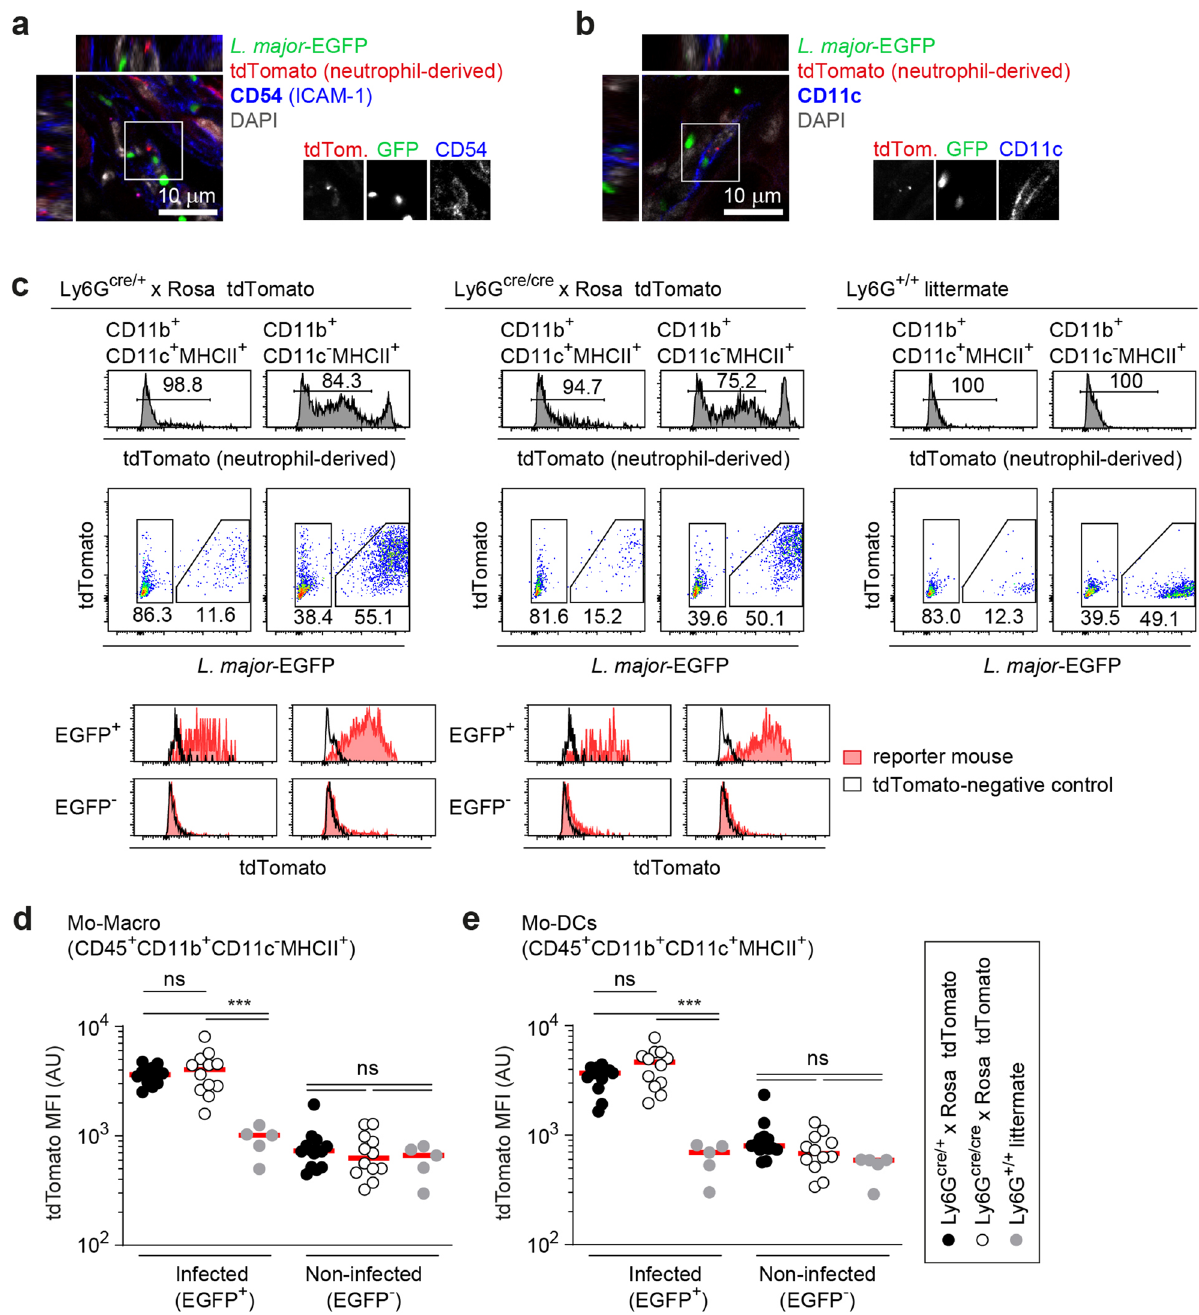
Figure 2. Uptake of neutrophil-derived material by monocyte-derived phagocytes is not altered by Ly6G-deficiency. ( a,b ) Confocal microscopy of Ly6G cre/+ × Rosa-tdTomato reporter mice infected with EGFP-expressing L. major 2 days p.i., demonstrating concomitant content of L. major parasites along with neutrophil-derived material in CD54 + ( a ) and CD11c + cells ( b ) and thus suggesting the uptake of L. major together with neutrophil material. Parasites are pictured in green and the neutrophil-derived material in red. Scale bar: 10 µm. ( c ) Flow cytometry analysis of infected cells from Ly6G cre/+ × Rosa-tdTomato reporter mice (left panel), Ly6G-deficient Ly6G cre/cre × Rosa-tdTomato (middle panel) and non-fluorescent Ly6G +/+ littermate control mice (right panel) are depicted. The upper row shows the histograms for quantification of the neutrophil-derived tdTomato signal (omitting the tdTomato high neutrophils) in mo-DCs (CD11b + CD11c + MHCII + ) and mo-macro (CD11b + CD11c - MHCII + ). Middle row: Gating on infected (EGFP + ) and non-infected (EGFP - ) population of phagocytes. Lower row: Exclusive uptake of neutrophil-derived tdTomato material in the L. major infected (EGFP + ), but not the uninfected cell population. Ly6G +/+ littermate control mice not expressing tdTomato certify that spectral overlap of EGFP and tdTomato is not responsible for the higher tdTomato-signal in infected cells. ( d,e ) Analysis of the mean fluorescence intensity (MFI) of neutrophil-derived tdTomato signal in control and Ly6G deficient mice for mo-macro ( d ) and mo-DCs ( e ) revealed that tdTomato content is Ly6G independent, Thus, the uptake of neutrophil material by recruited monocyte- derived phagocytes is not altered due to Ly6G deficiency. Infected and non-infected cells are shown from Ly6G cre/+ × Rosa-tdTomato (black symbols), Ly6G cre/cre × Rosa-tdTomato mice (white symbols) and Ly6G +/+ littermates (grey symbols). Each dot represents one infected ear. Horizontal bars represent mean; ***p < 0.001; ns not significant as determined by one-way ANOVA with Bonferroni post test for multiple